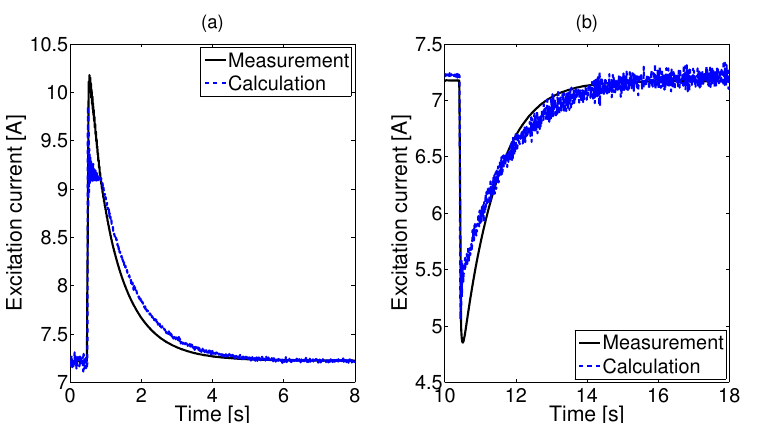
Figure 12. Comparison of the measured and calculated excitation current of the synchronous genera- tor during active-reactive load switched on ( a ) and off ( b ).